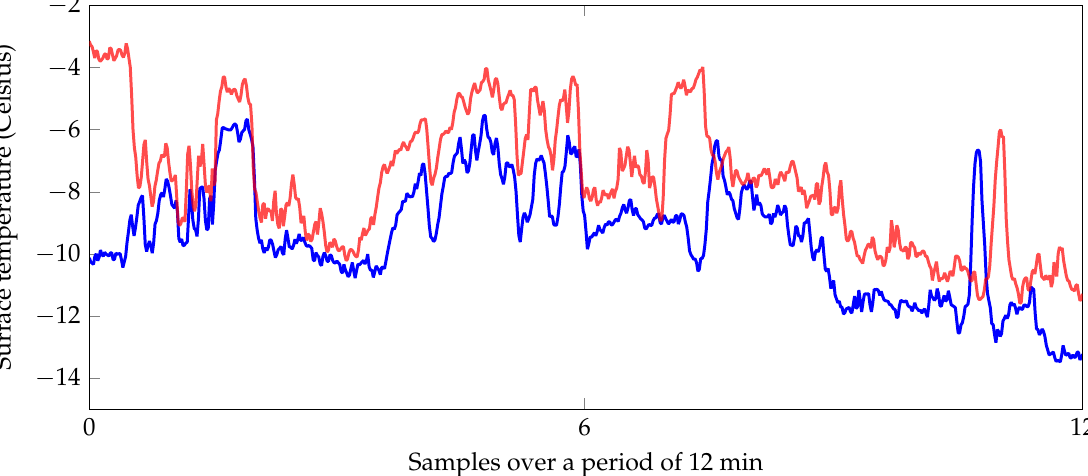
Figure 4. RCM411 surface temperature plots from two runs along the same test route: blue, run 1; red, run